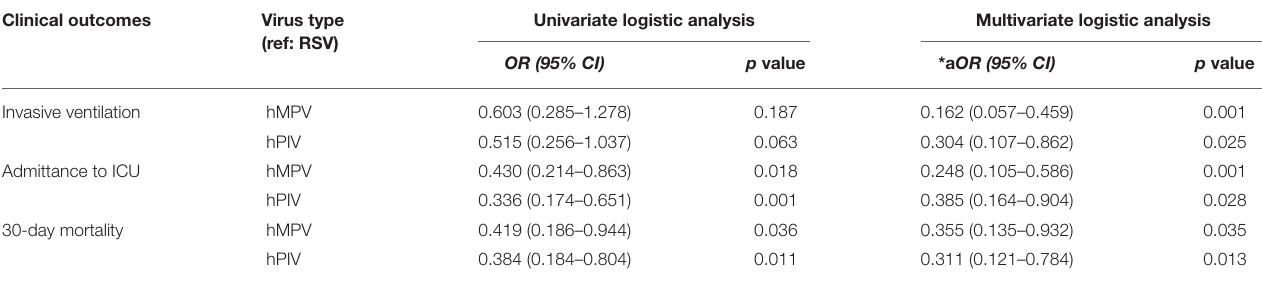
TABLE 3 | The impact of virus types on the clinical outcomes of PMVs-p. Clinical outcomes